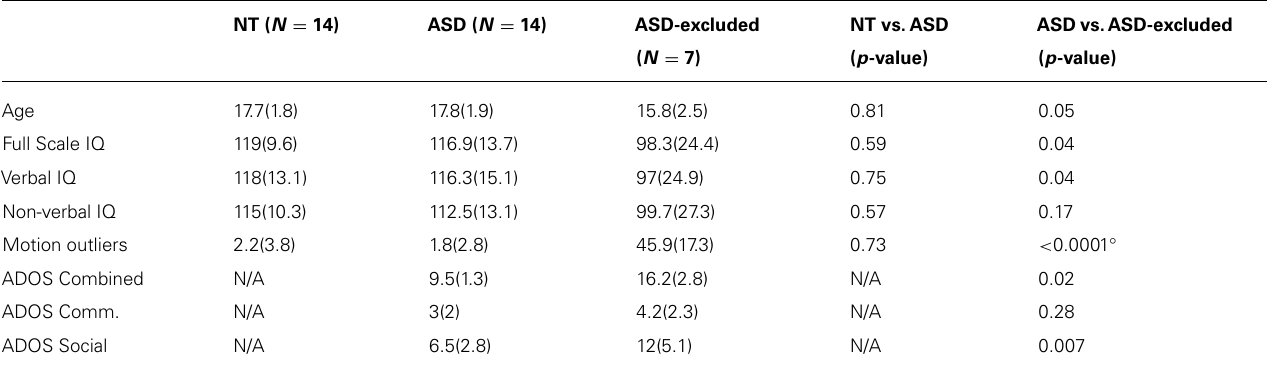
Table 1 | Demographic and head motion information for NT andASD groups and thoseASD participants excluded due to excessive head